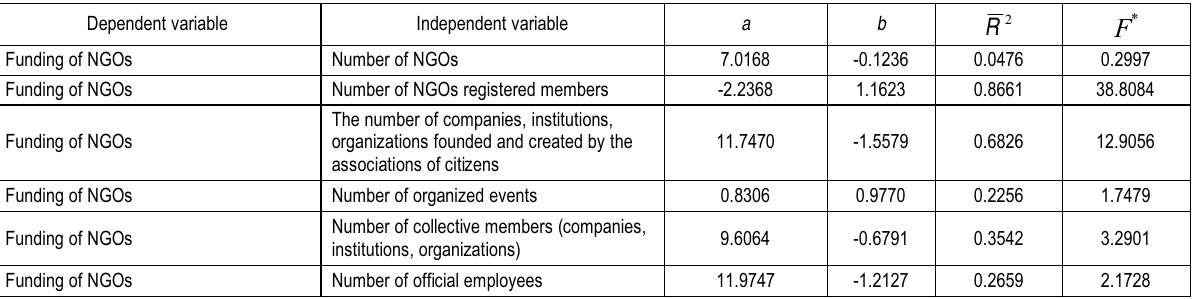
Table 6.The study of paired relation between indices of funding of NGOs and the quantitative indices of their